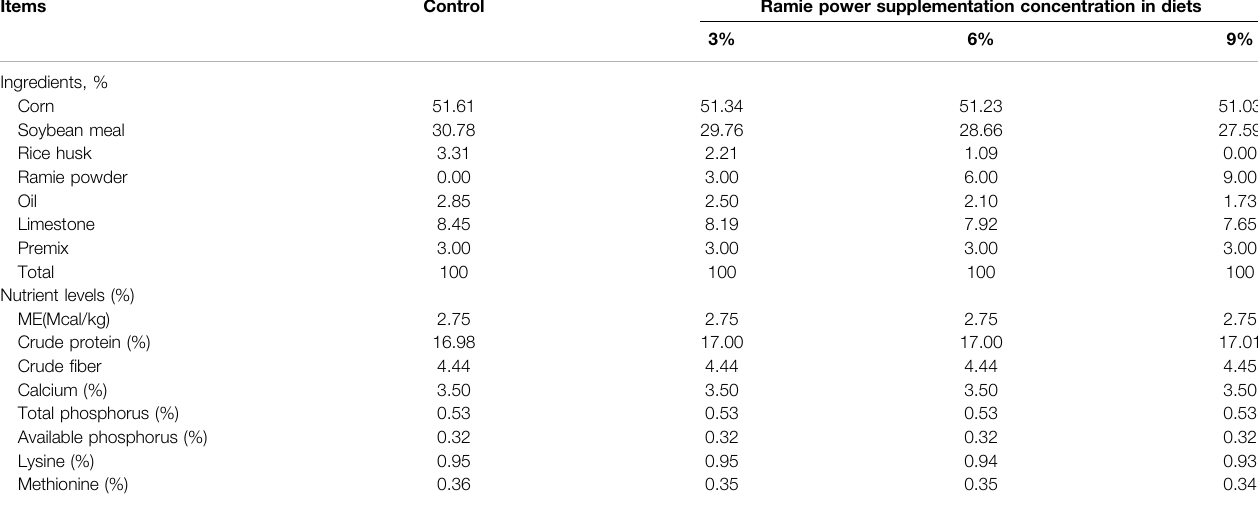
TABLE 1 | Diet formulation and calculated nutrients (air-dried basis,